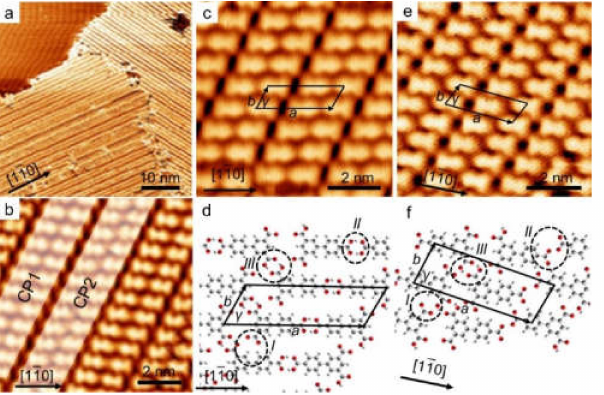
Figure 2. CP1 and CP2 structures after a 440 K annealing. ( a ) An STM overview ( U = − 1.4 V, I = 200 pA). ( b ) An STM image ( U = − 0.6 V, I = 200 pA) of the domain containing both CP1 and CP2 (highlighted in white). ( c , d ) High-resolution STM image ( U = − 1.2 V, I = 50 pA) of CP1 and the corresponding structural model. Ovals indicate different intermolecular bonding motifs. ( e , f ) High-resolution STM image ( U = − 1.2 V, I = 50 pA) of CP2 and the corresponding structural model. Ovals present different intermolecular bonding motifs.